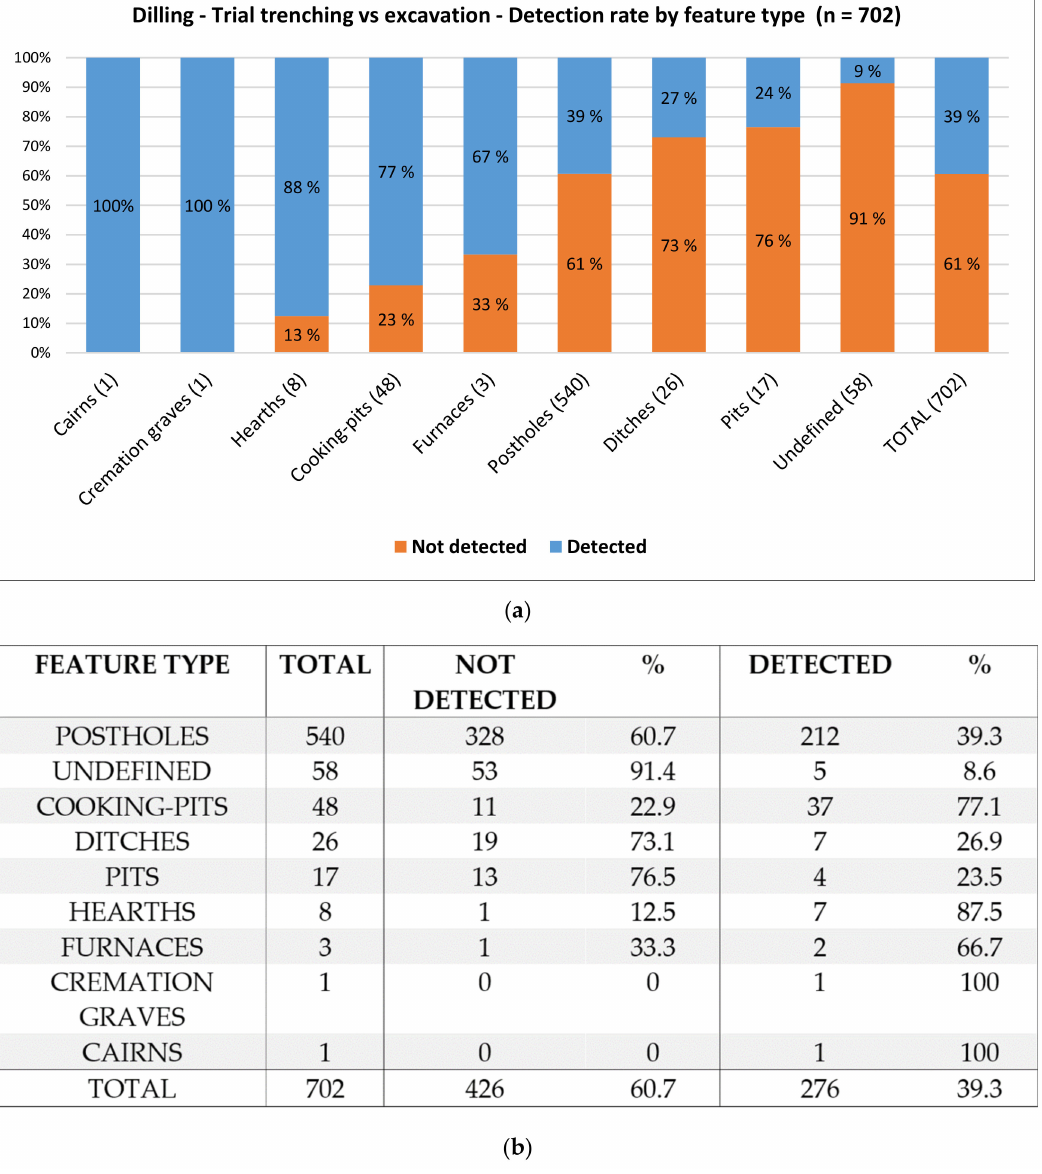
Figure 11. ( a , b ) Charts showing the relationship between detected and non-detected features within the boundaries of the trial trenches at